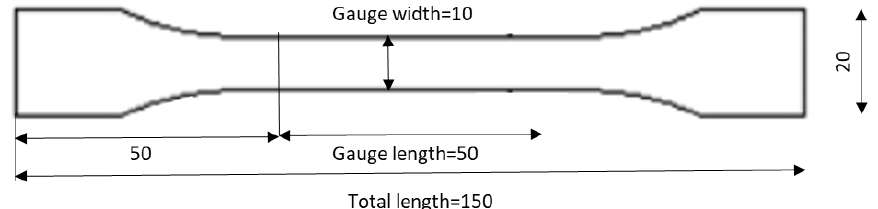
Figure 2. Geometry of the bulk tests specimen (dogbone) according to BS 2782 with the thickness of 2 mm, not shown in this image, (dimensions in mm).